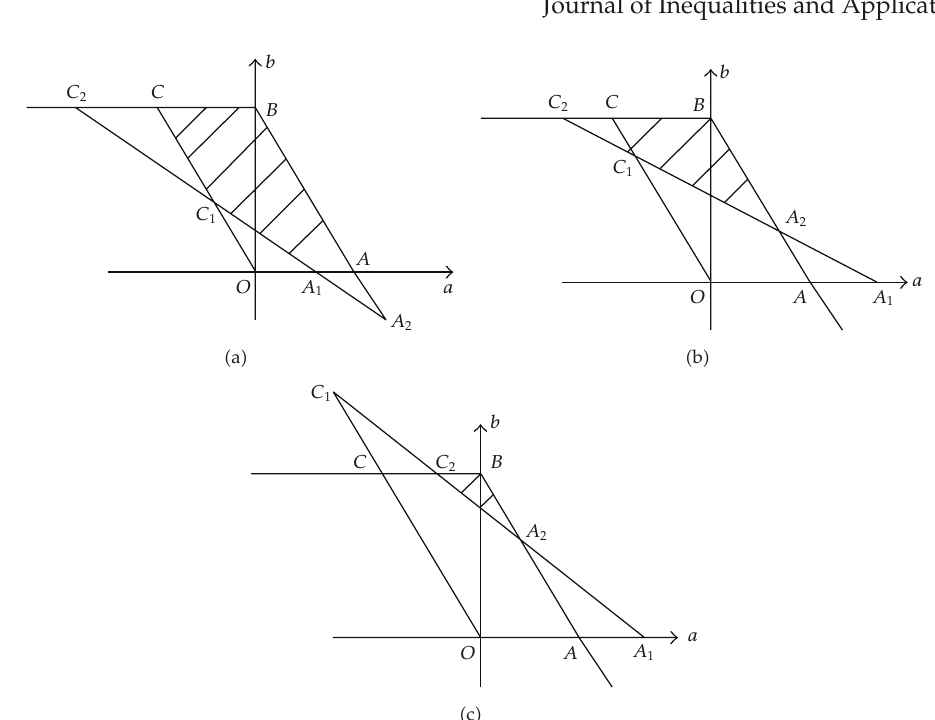
Figure 1: Feasibility areas for di ff erent cases of the collected tax amount R